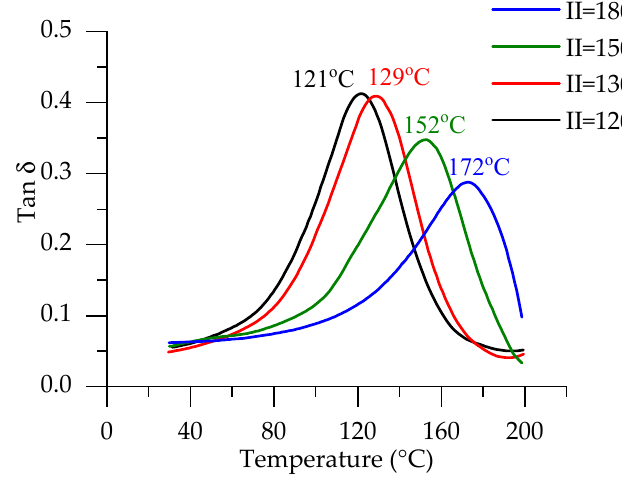
Figure 3. Damping factor curves of RO/PET series rigid PUR foams.